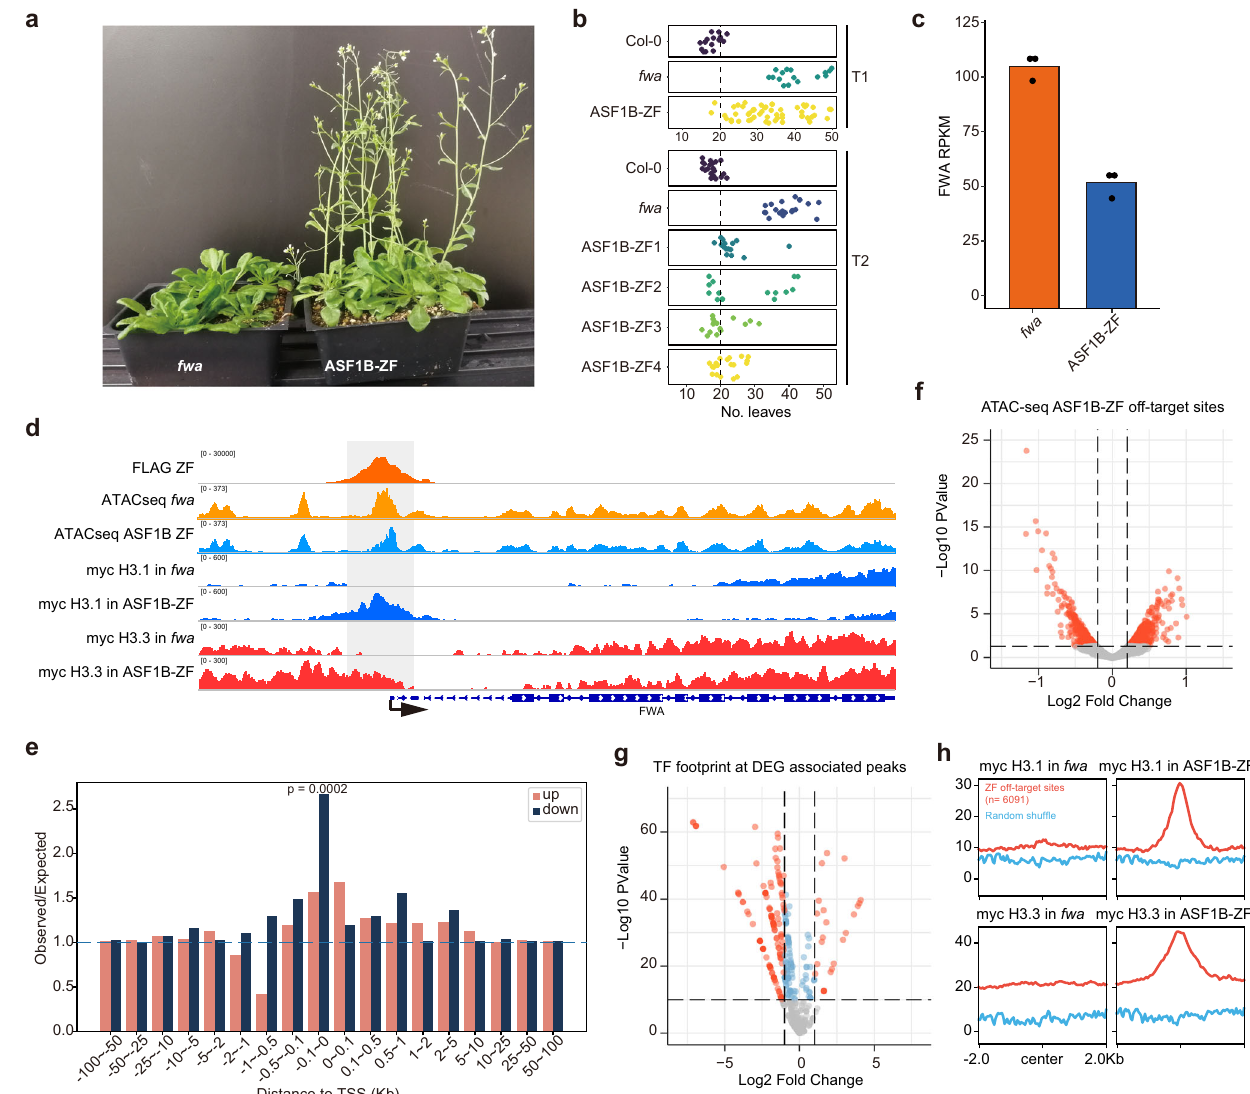
Fig. 7 | Effects of the targeting of ASF1B to FWA promoter. a Morphological phenotype and fl owering time of fwa-4 and T 1 fwa-4 + ASF1B-ZF108-3xFlag . b The total leaf number of Col-0, fwa-4 , T 1 fwa-4 + ASF1B-ZF108-3xFlag , and four T 2 fwa- 4 + ASF1B-ZF108-3xFlag lines. c FWA expressionlevelin fwa-4 and T 1 fwa-4 + ASF1B- ZF108-3xFlag . n =3 biologically independent plants examined. d Screenshot showing ASF1B-ZF108-3x Flag binding, chromatin accessibility assayed by ATAC- Seq, and expression level at FWA . e Observed vs. expected ratio of the association of ASF1B-ZF108-3xFlag binding peaks ( n =6091) and DEGs in ASF1B-ZF108-3xFlag